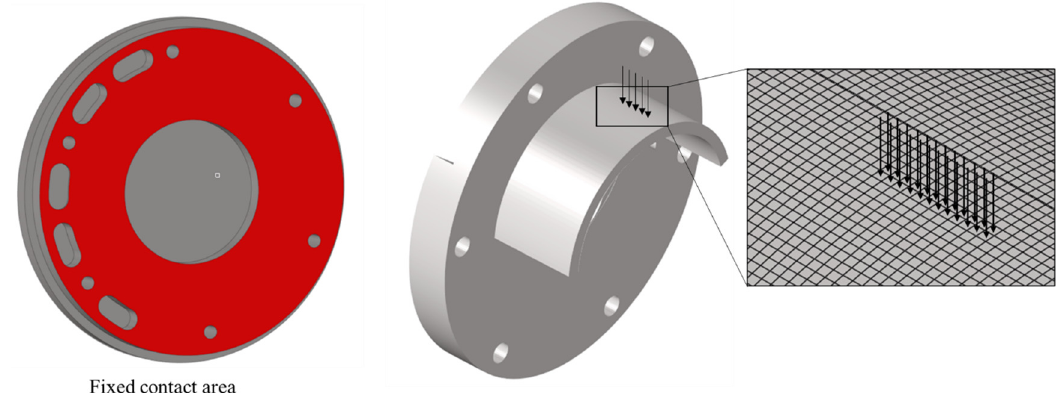
Figure 6 . The constraint and loading conditions of the C-specimen FEM models.